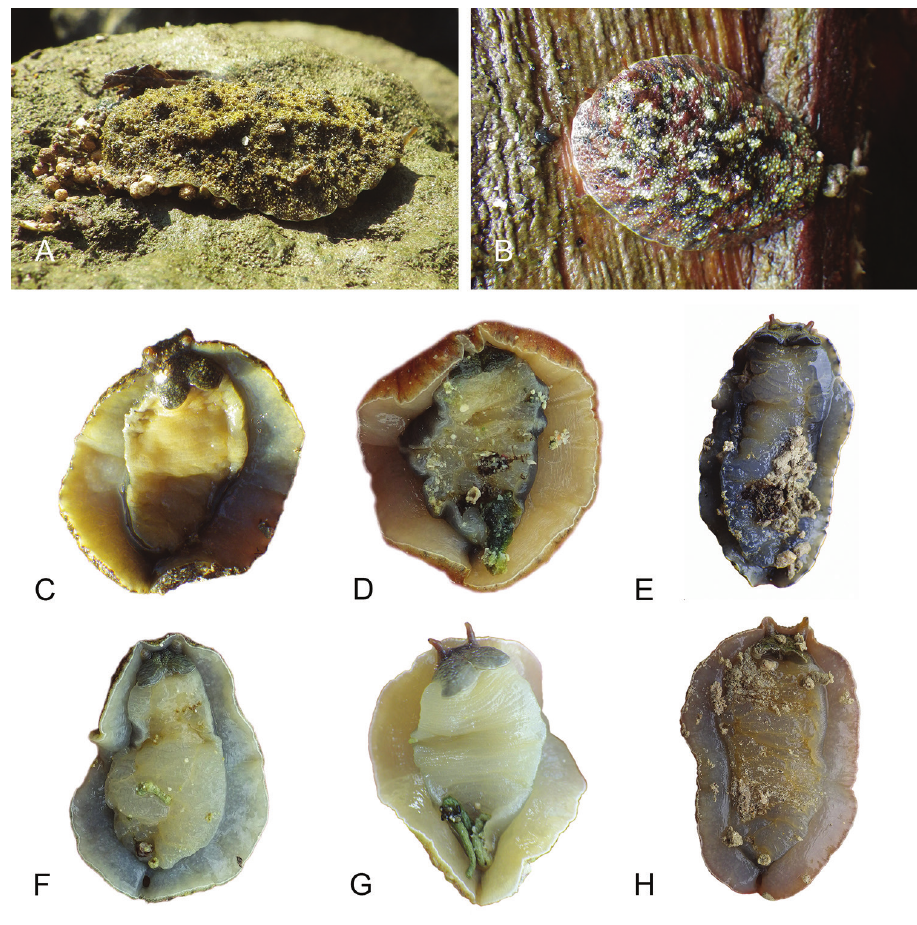
Figure 37. Live specimens, Wallaconchis ater . A Dorsal view, 43 mm long [2970], Indonesia, Lombok (UMIZ 00043) B Dorsal view, 37 mm long [2170], Indonesia, Sulawesi (UMIZ 00036) C Ventral view, 35 mm long [2974], Indonesia, Lombok (UMIZ 00043) D Ventral view, 36 mm long [3266], Philip- pines, Bohol (PNM 041214) E Ventral view, 26 mm long [3405], Philippines, Bohol (PNM 041219) F Ventral view, 33 mm long [3272], Philippines, Bohol (PNM 041214) G Ventral view, 32 mm long [3277], Philippines, Bohol (PNM 041222) H Ventral view, 37 mm long [3420], Philippines, Bohol (PNM